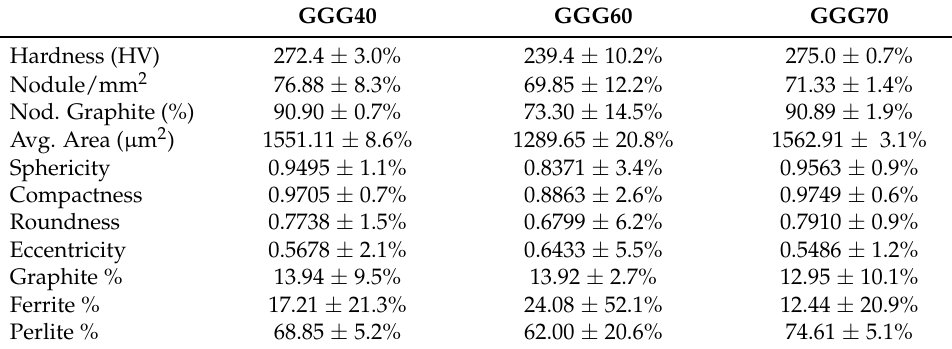
Table 6. Final results averages for NCI GGG40, 60 and 70 bar specimens.